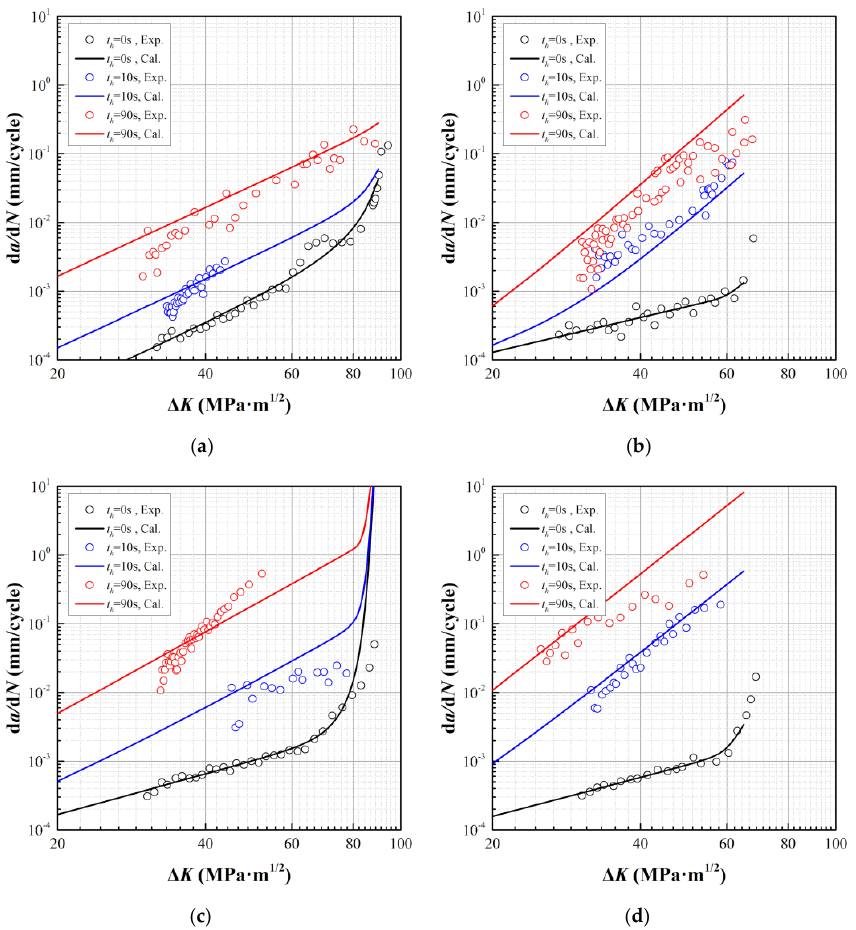
Figure 7. Experimental and predicted d a /d N under pure fatigue and creep-fatigue. ( a ) T = 600 °C, R